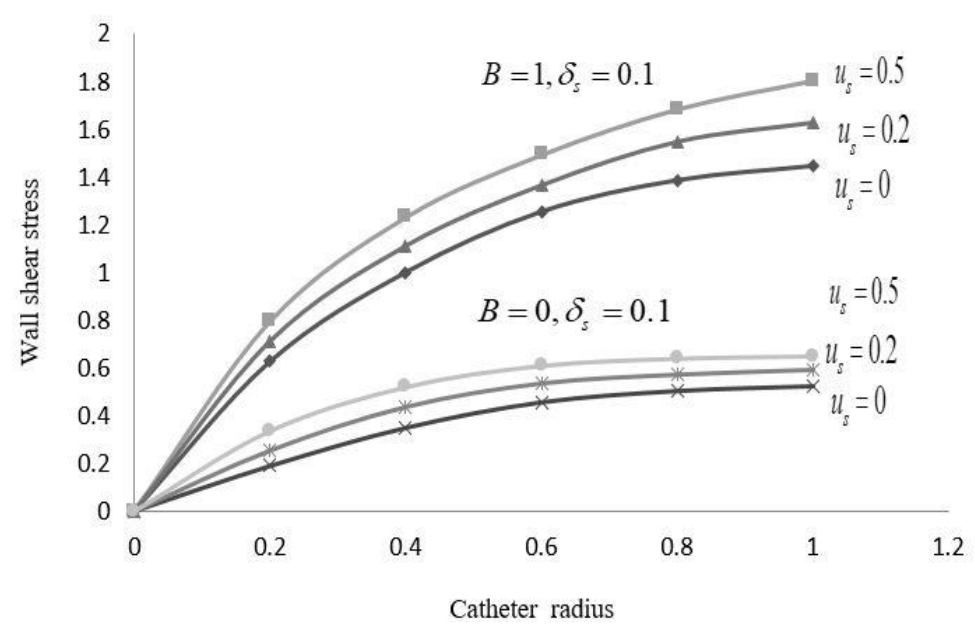
Figure 3. Rate of flow Q with pressure gradiente for B